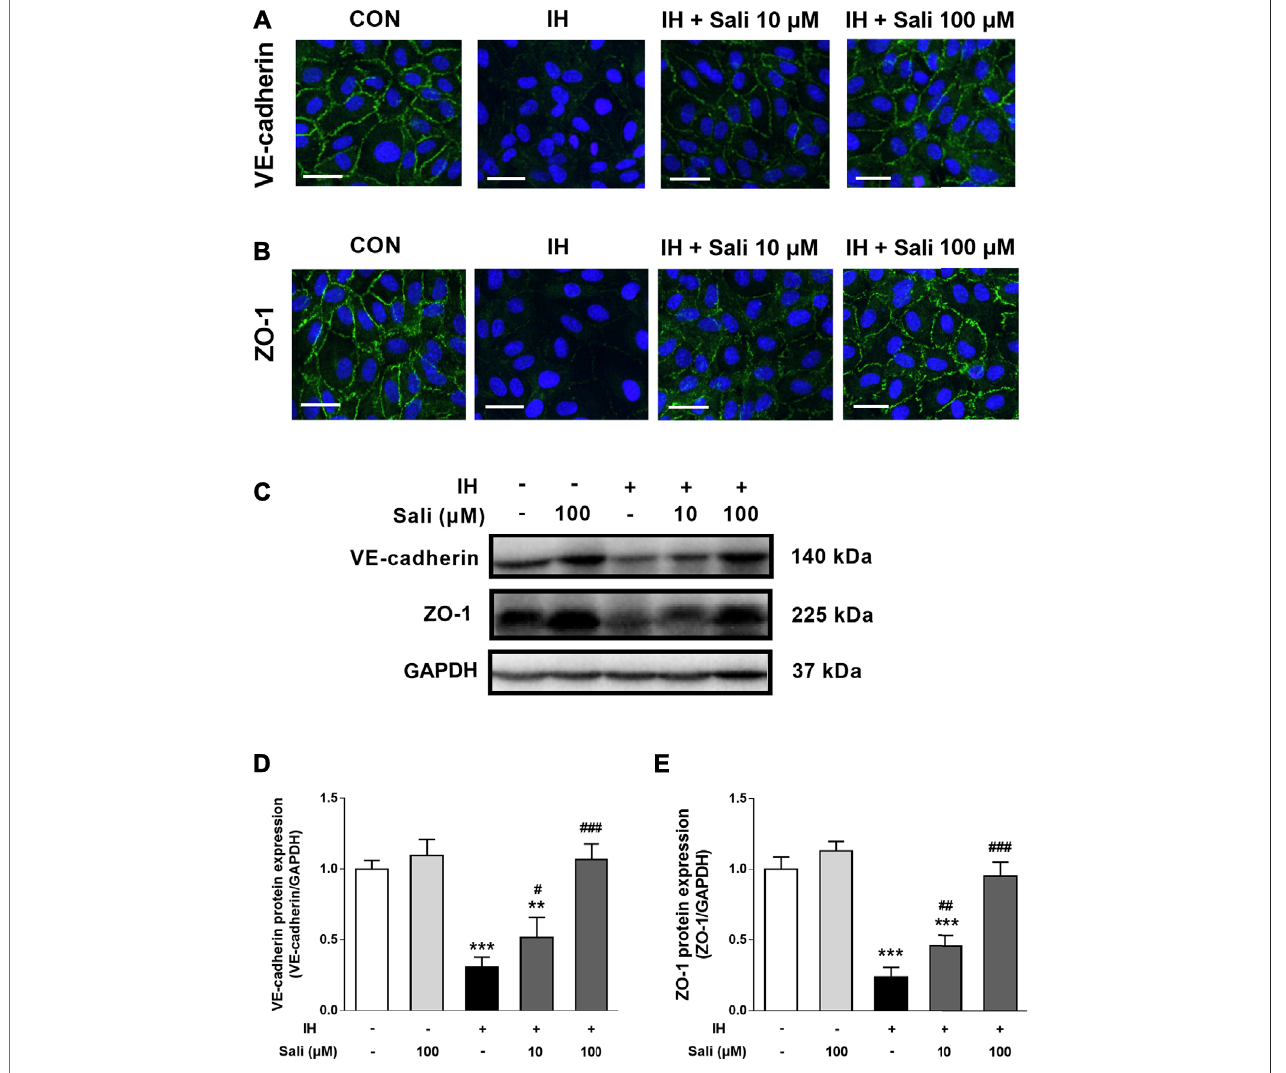
FIGURE 3 | Salidroside ameliorated the suppressive effect of IH on VE-cadherin and ZO-1 expression in HUVECs. HUVECs were pretreated with Sali (10 µM or 100 µM) for 2 h before exposure to 72 cycles of IH (A) Immuno fl uorographs of VE-cadherin (20 × magni fi cation; Bar (cid:1) 50 µm) and (B) ZO-1 (20 × magni fi cation; Bar (cid:1) 50 μ m) (C) VE-cadherin and ZO-1 protein levels were measured by western blot analysis (D – E) Relative protein levels of VE-cadherin and ZO-1 were quanti fi ed by densitometry analysis. IH, intermittent hypoxia; Sali, salidroside; VE-cadherin, vascular endothelial cadherin; ZO-1, zonula occludens 1. All data are presented as mean ± SD. # p < 0.05, ## p < 0.01, and ### p < 0.001 compared with IH group; ** p < 0.01 and *** p < 0.001 compared with normoxia group.